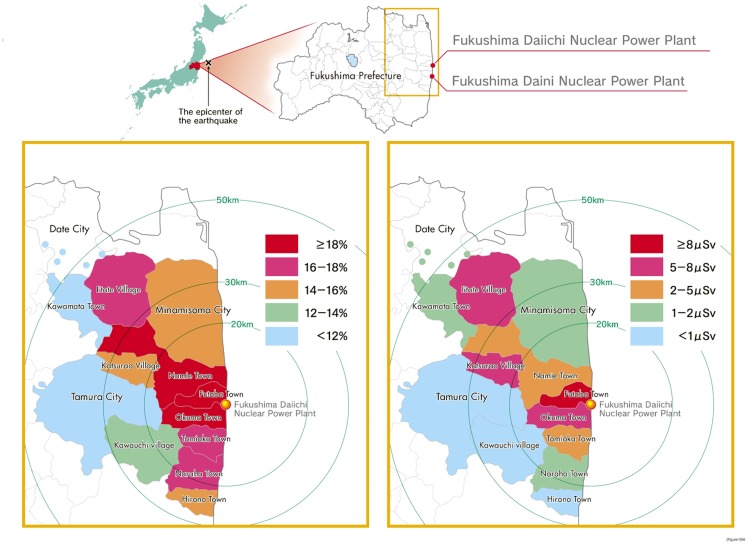
The distribution of psychological distress in evacuation zone (A) and environmental radiation levels (μsV/h) in evacuation zone (B). The distribution of psychological distress showed pattern similar to the environmental radiation levels on a prefectural map of Fukushima (based on the levels reported in a local newspaper Fukushima Minpo dated January 20, 2012). Spearman’s rank correlation showed that the proportion of those in the evacuation zone who scored ≥13 on the K6 was significantly highly correlated with the environmental radiation levels (r = 0.768, p = 0.002). The 18% in (A) means the area where more than 18% of the participants scored >13 on the K6, and >8 μSv in (B) means the area where >8 μSv/h was recorded. Original maps were created by tracing copyright-free materials (http://kage-design.com/wp/?p=1061 and http://www.civilcom.co.jp/library/WhiteMapJapan/#07) and then drawing the content using Adobe Illustrator CS6 (Adobe Systems Inc., San Jose, CA).